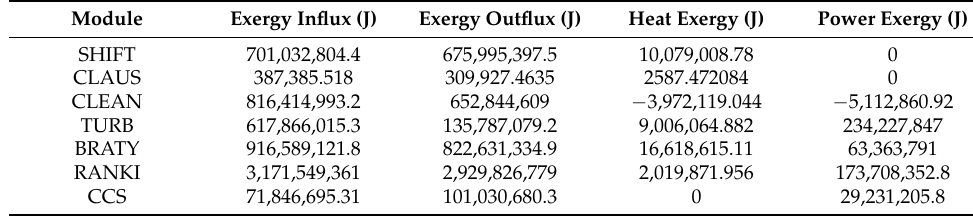
Table 12. Summary of the exergy flux of each